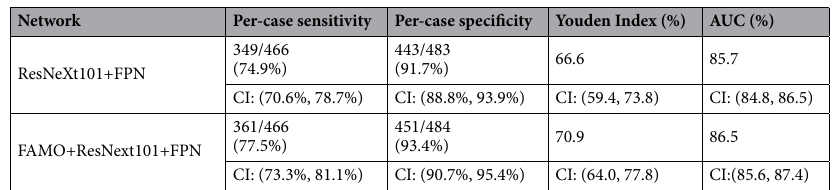
Network Per-case sensitivity Per-case specificity Youden Index (%) AUC